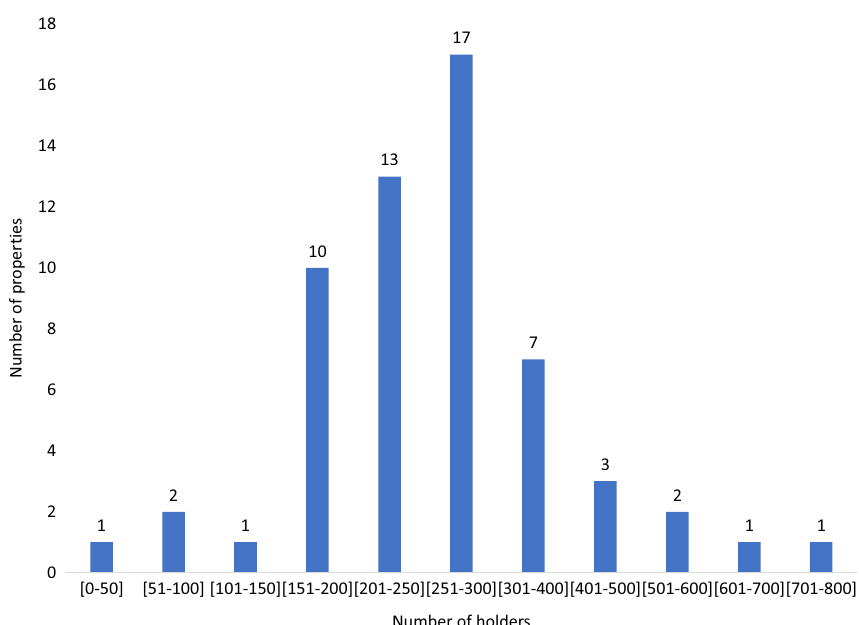
Fig. 1 Histogram of the number of holders per property. Figure based on data from March 2021. Contains ownership of the 58 properties in Table